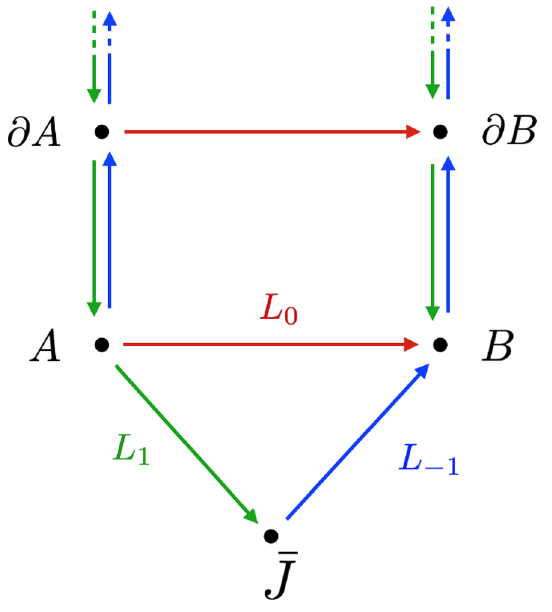
Figure 3. The structure of the staggered module for the currents (colors online). For simplicity we only indicate the action of L 0 and L (cid:6) 1 . B is both a descendant and a primary, while A is neither a descendant nor a